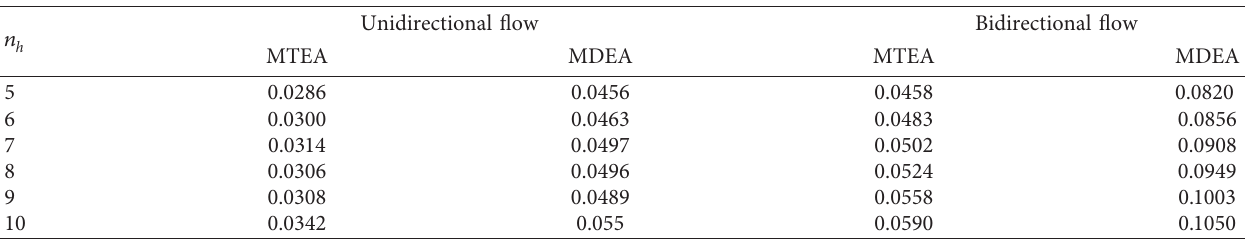
Table 5: MTEA and MDEA of simulation cases considering different numbers of historical movement steps.